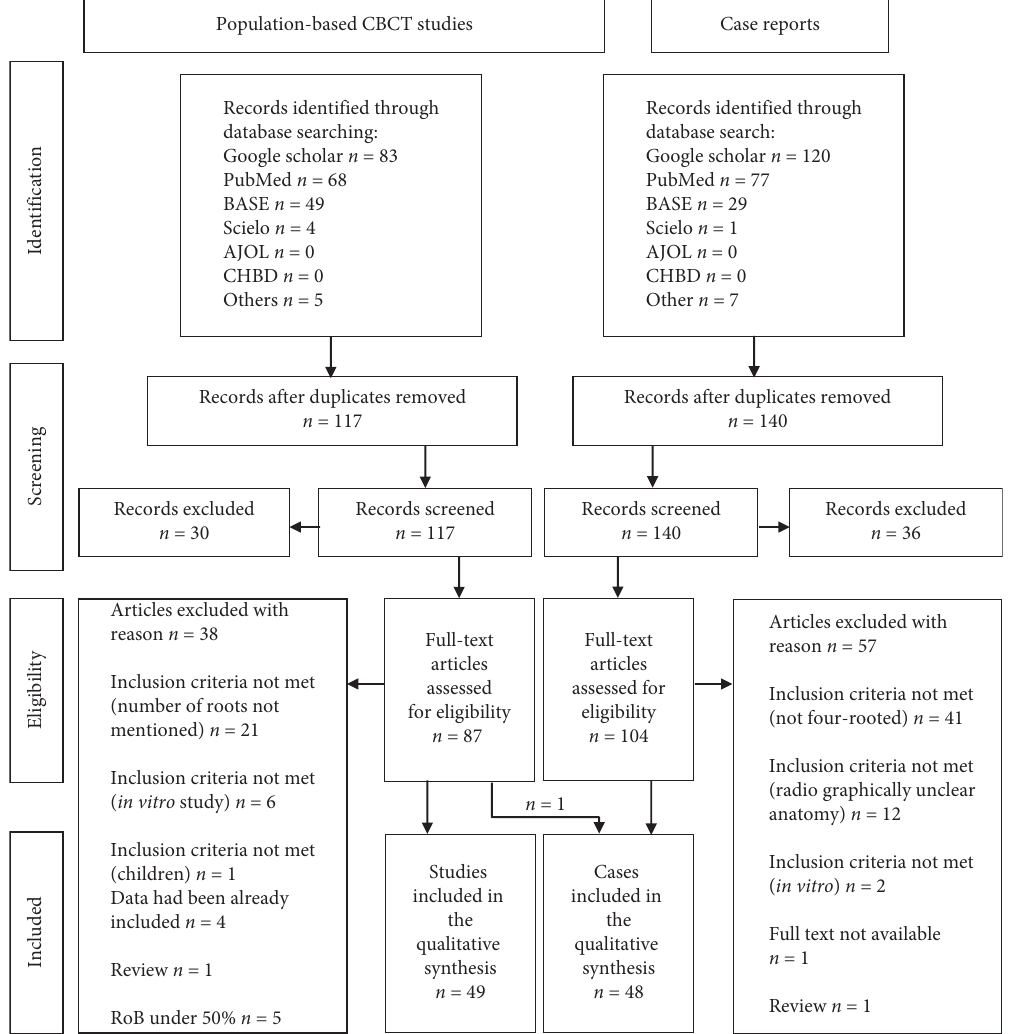
Figure 3: Flowchart summarizing the search strategy and